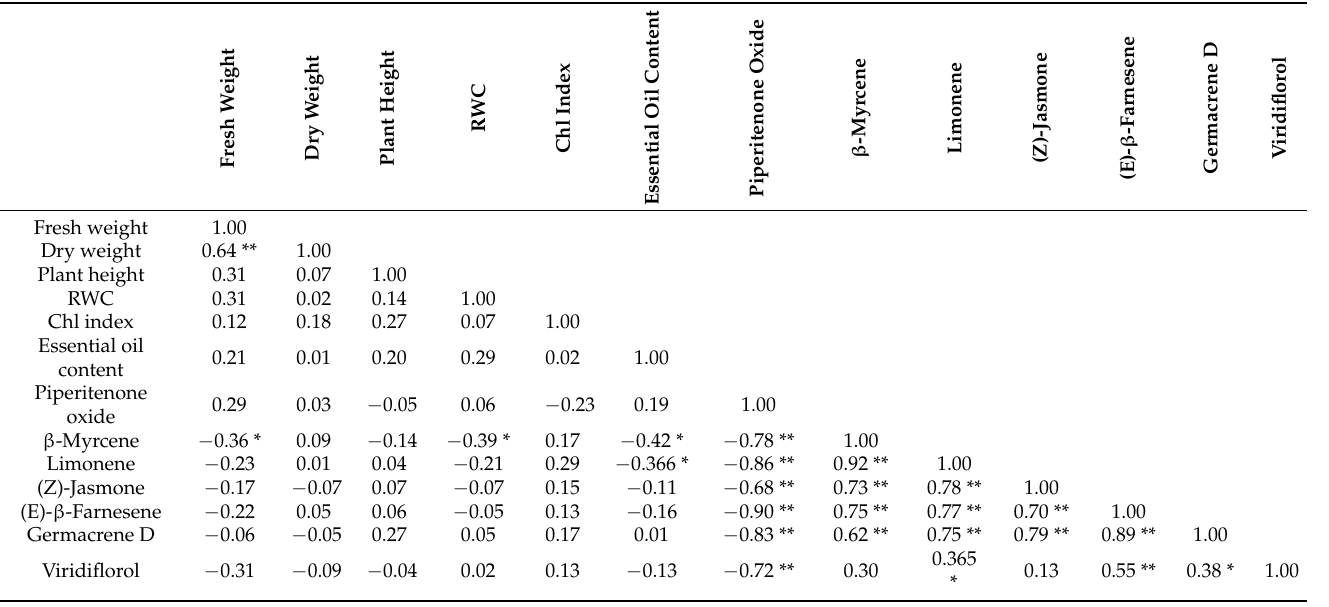
Table 2. Pearson’s correlation coefficients among grows parameters, essential oil content and compo- sitions of pineapple mint under different salinity stress and selenium nanoparticle